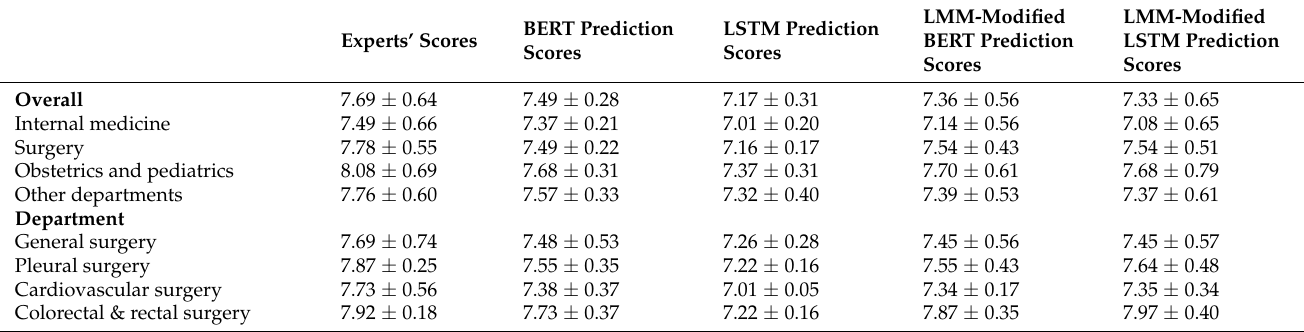
Table 2. BERT and LSTM original prediction scores and LMM-modified